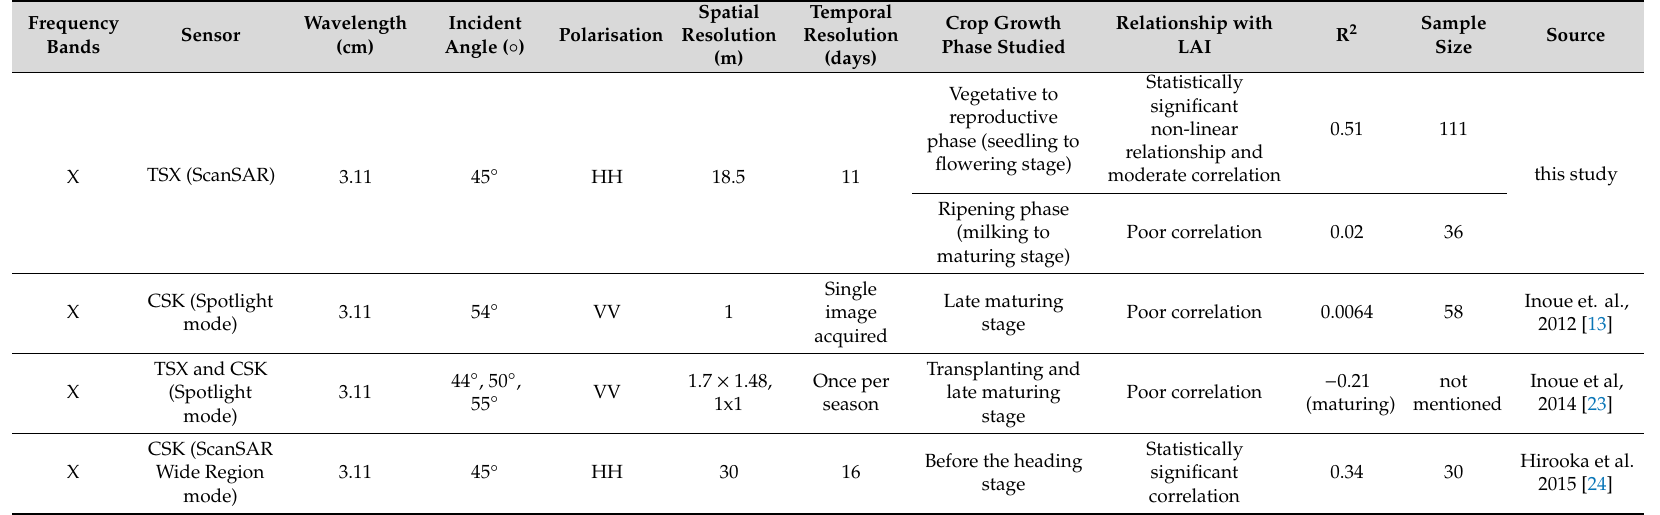
Table 3. Summary of findings from this study and previous studies on the relationship between X-band backscattering intensity ( σ ◦ ) and rice crop’s